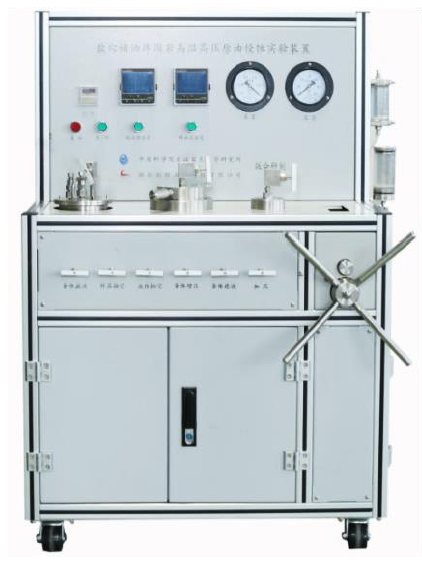
Figure 4. The immersion test device.